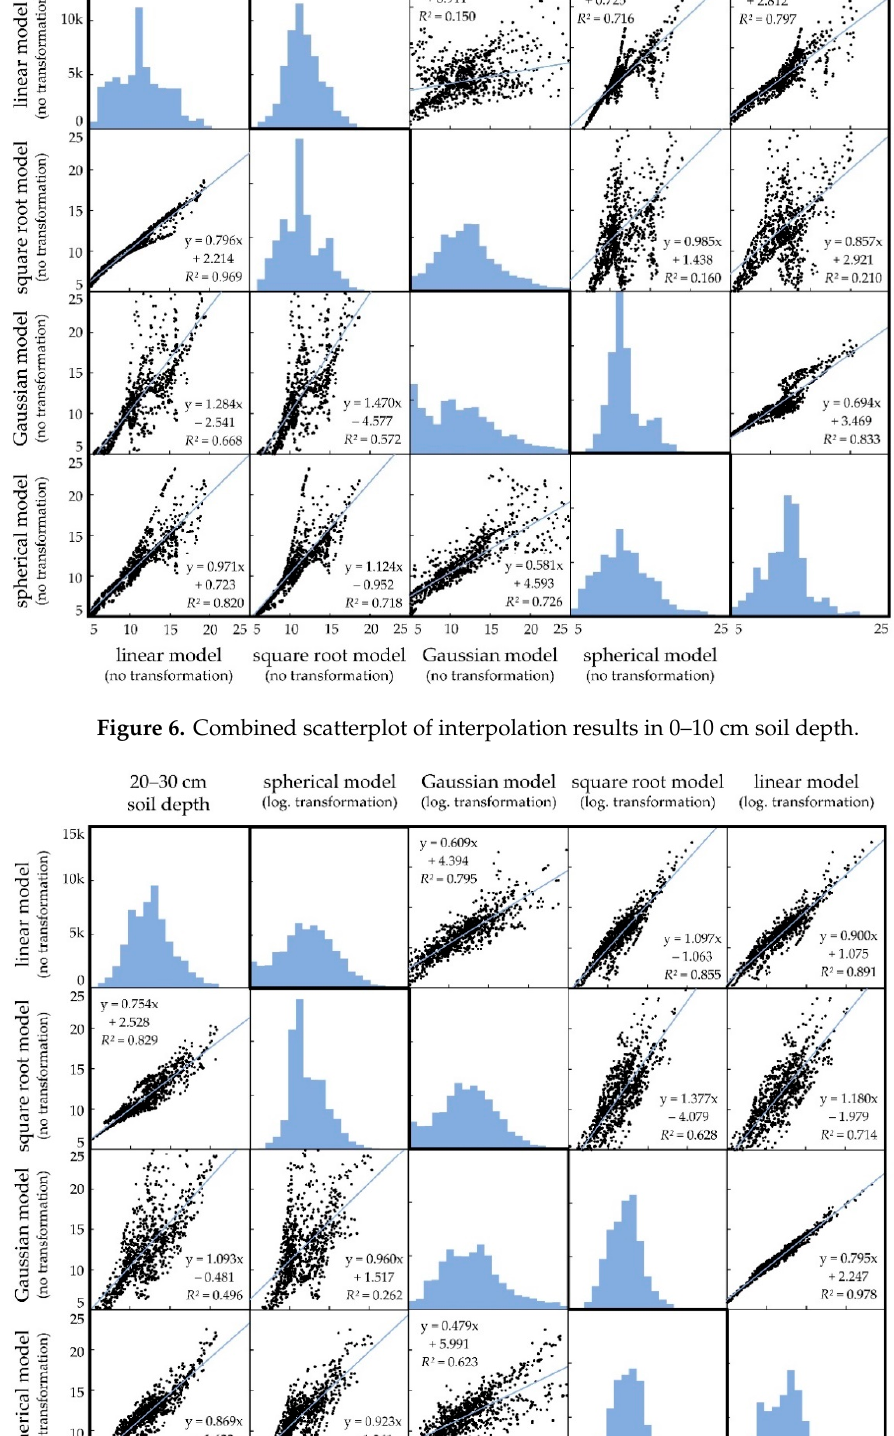
Figure 7. Combined scatterplot of interpolation results in 20–30 cm soil depth.